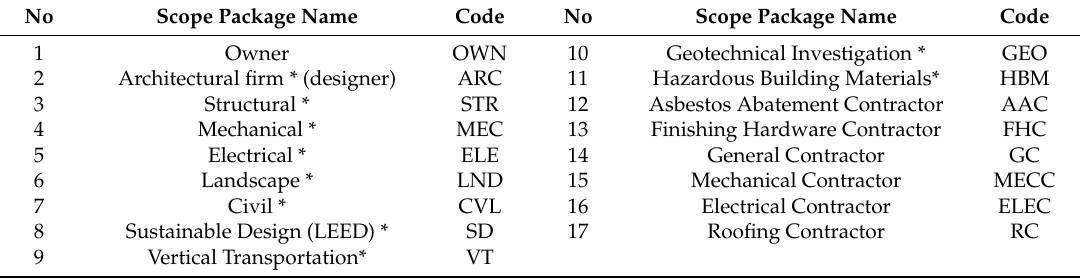
Table 2. Project stakeholders in the case